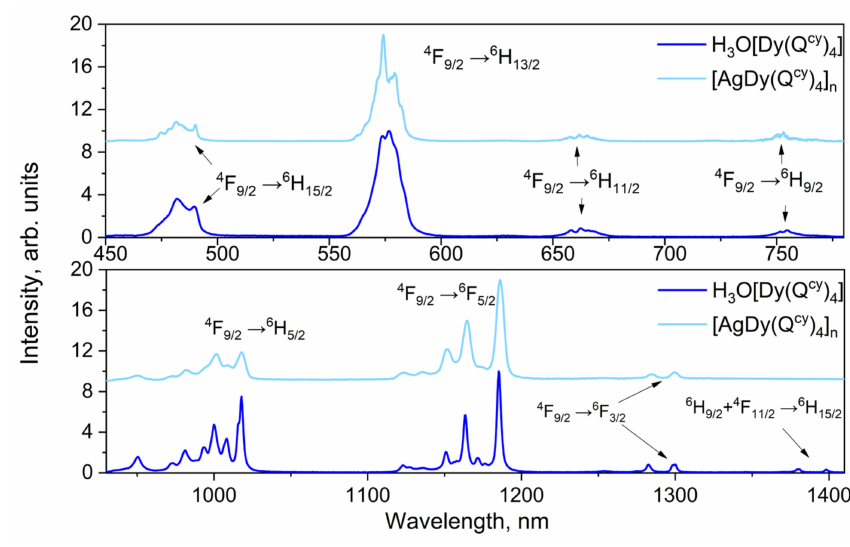
Figure 8. Photoluminescence spectra for Dy 3+ complexes 5 and 10